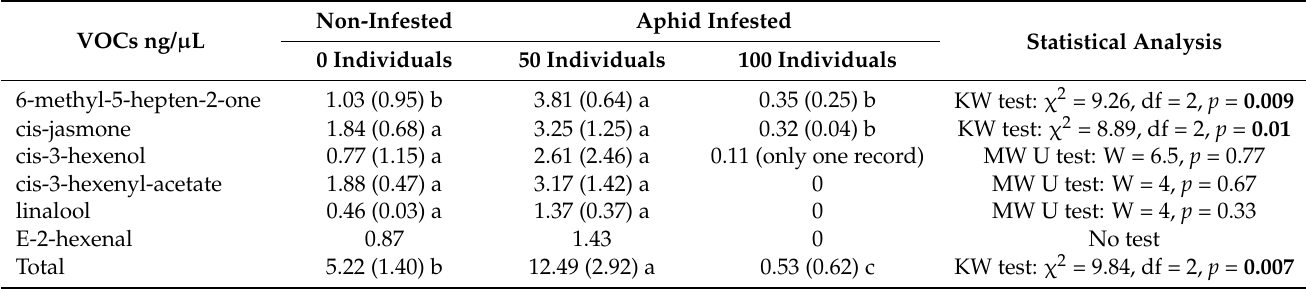
Table 3. Volatile organic compounds from aphid-infested plants (50 and 100 individuals) and non-infested plants. Data are presented as median (IQR). Small letters represent significant difference among